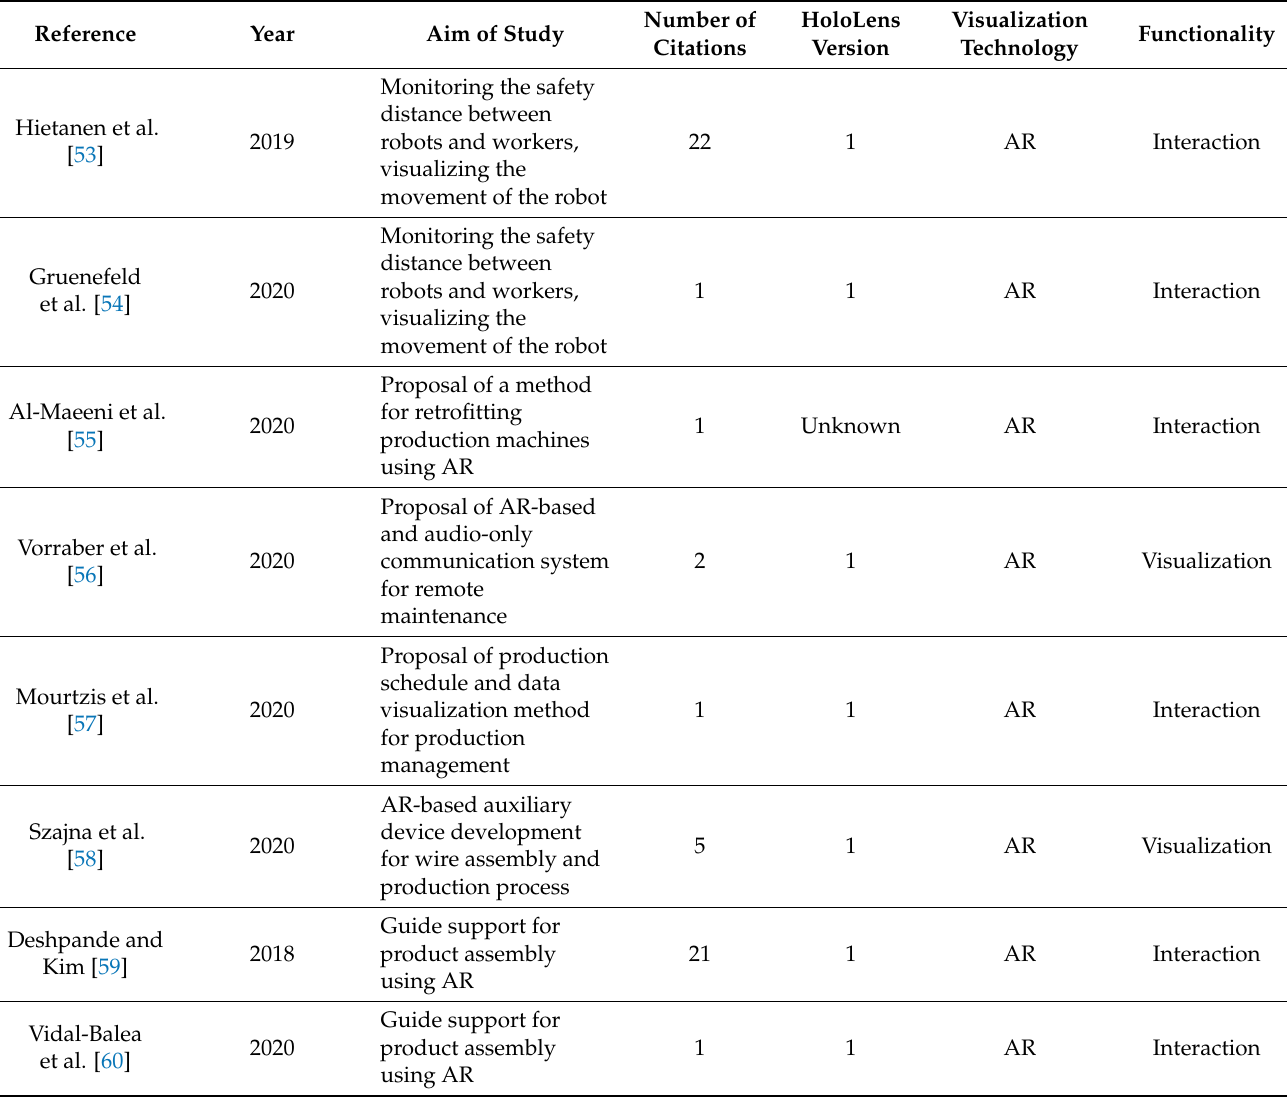
Figure 9. Interaction between two devices with a shared 3D element ( Left ) and the assembly process at Navantia’s Turbine workshop ( Right ) [60]. Table 4. Summary of Microsoft HoloLens application for industrial